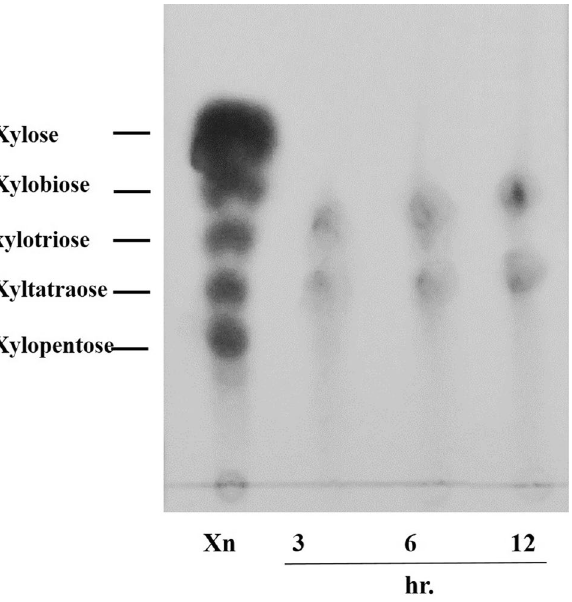
Figure 3. TLC analysis of hydrolysis of beechwood xylan by the endo-1,4-β-xylanase from T. dupontii KKU– CLD–E2–3: standard xylose and xylooligosaccharide marker (Xn) and time of incubation